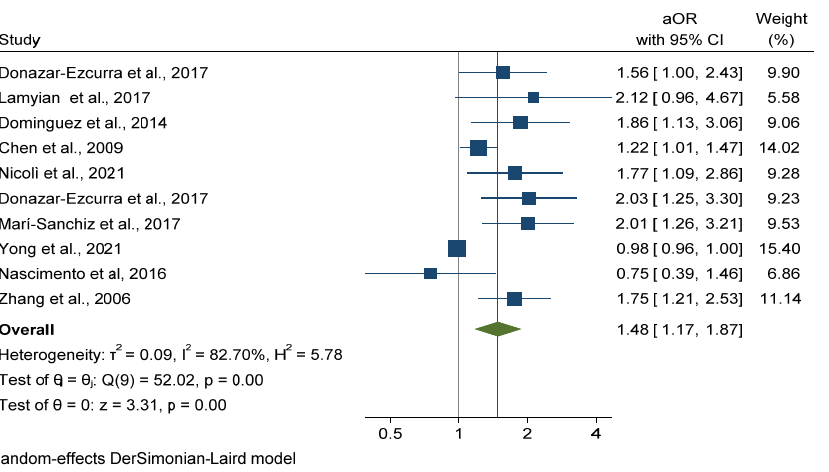
Figure 3. Meta-analysis of ultra-processed food rich diet vs gestational diabetes mellitus.